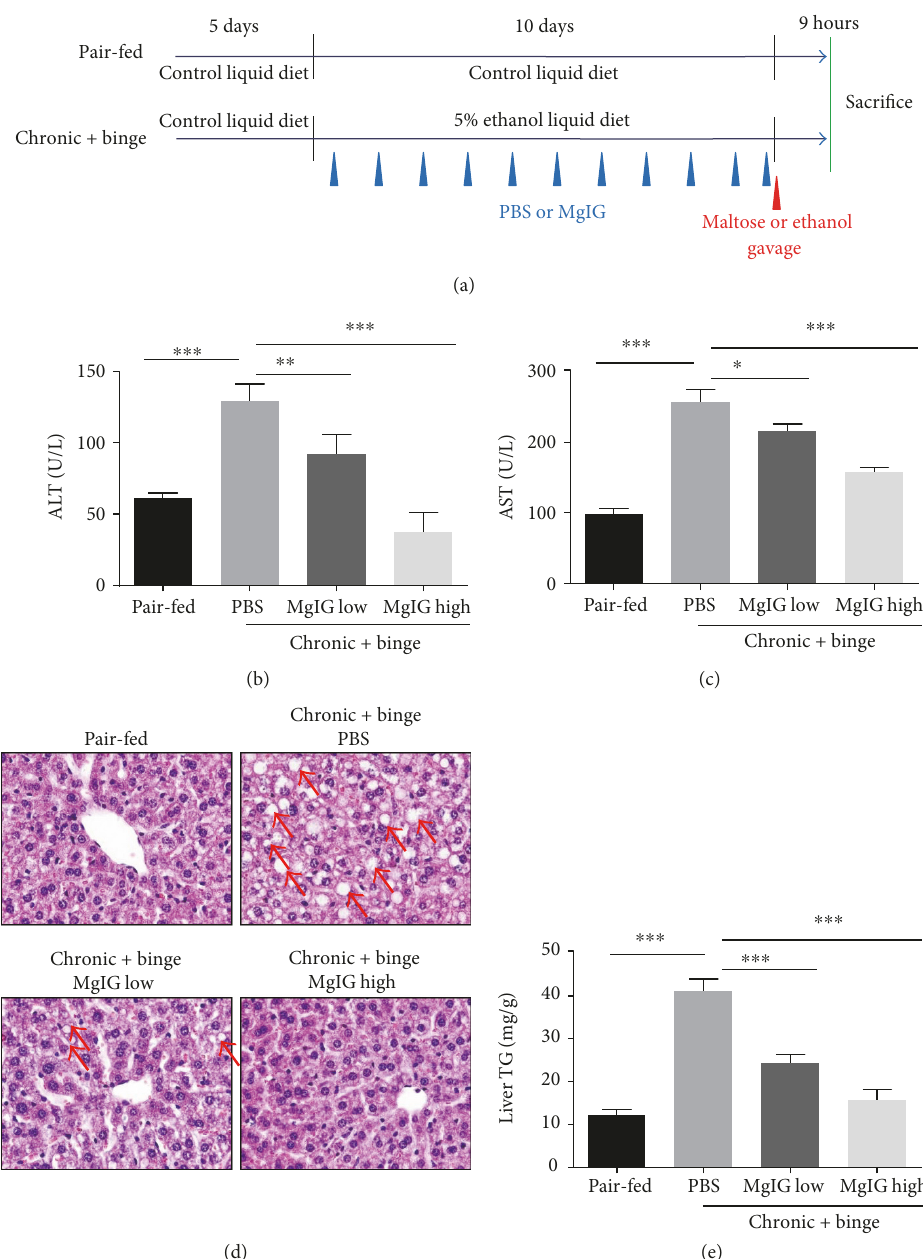
Figure 1: Protective e ff ect of MgIG treatment against chronic plus binge ethanol feeding-induced hepatic injury. (a) Experimental design of liquid control or ethanol diet feeding and drug treatments. Mice were treated as described in (a); liver injury was assessed by measuring serum alanine aminotransferase (ALT) levels (b) and aspartate aminotransferase (AST) levels (c). (d) Representative H&E staining. Arrows indicate macrovesicular and microvesicular steatosis. (e) Hepatic triglyceride (TG) levels were measured. Values represent means ± SEM. ∗ p < 0 05 ; ∗∗ p < 0 01 ; ∗∗∗ p < 0 001